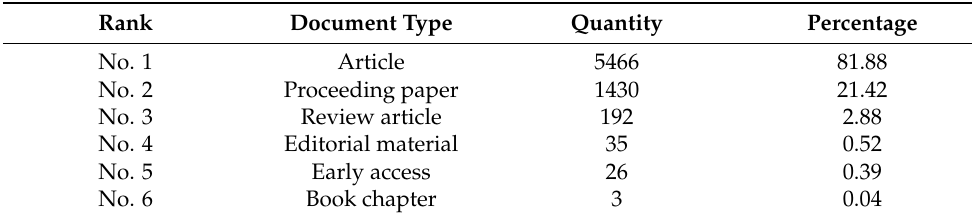
Table 1. Document types and quantities for publications on hydrogen embrittlement.